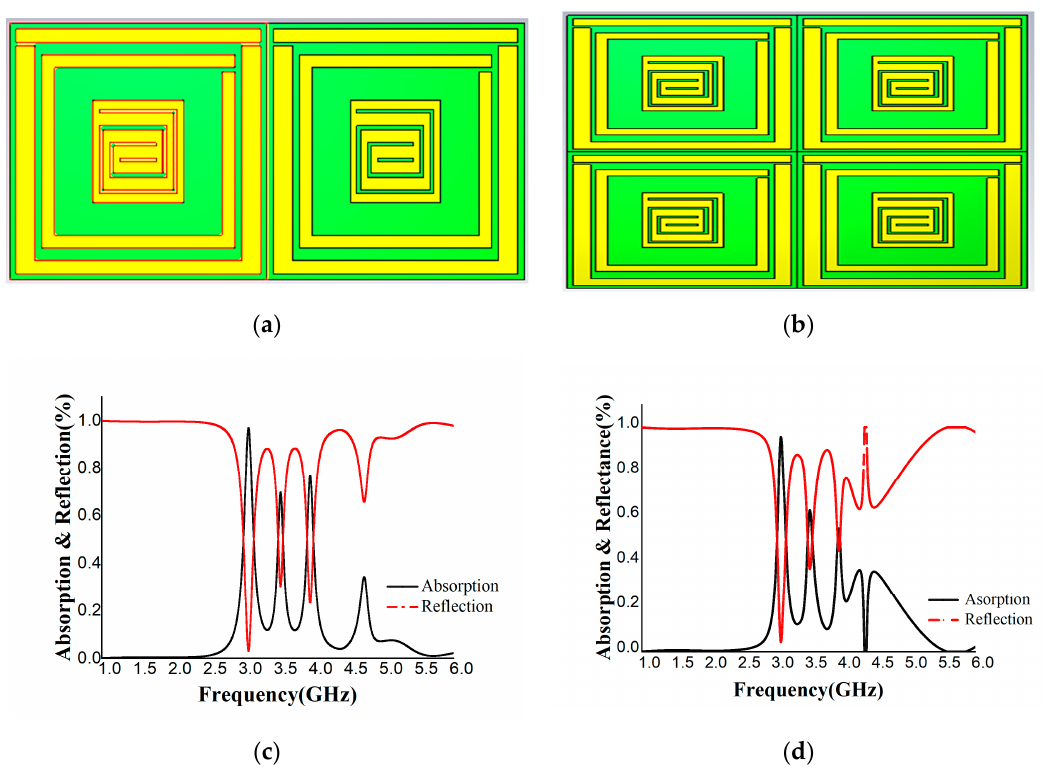
Figure 12. Depiction of the ( a ) 1 × 2 array and ( b ) 2 × 2 array. Absorption and reflection of the ( c ) 1 × 2 array and ( d ) 2 × 2 array.